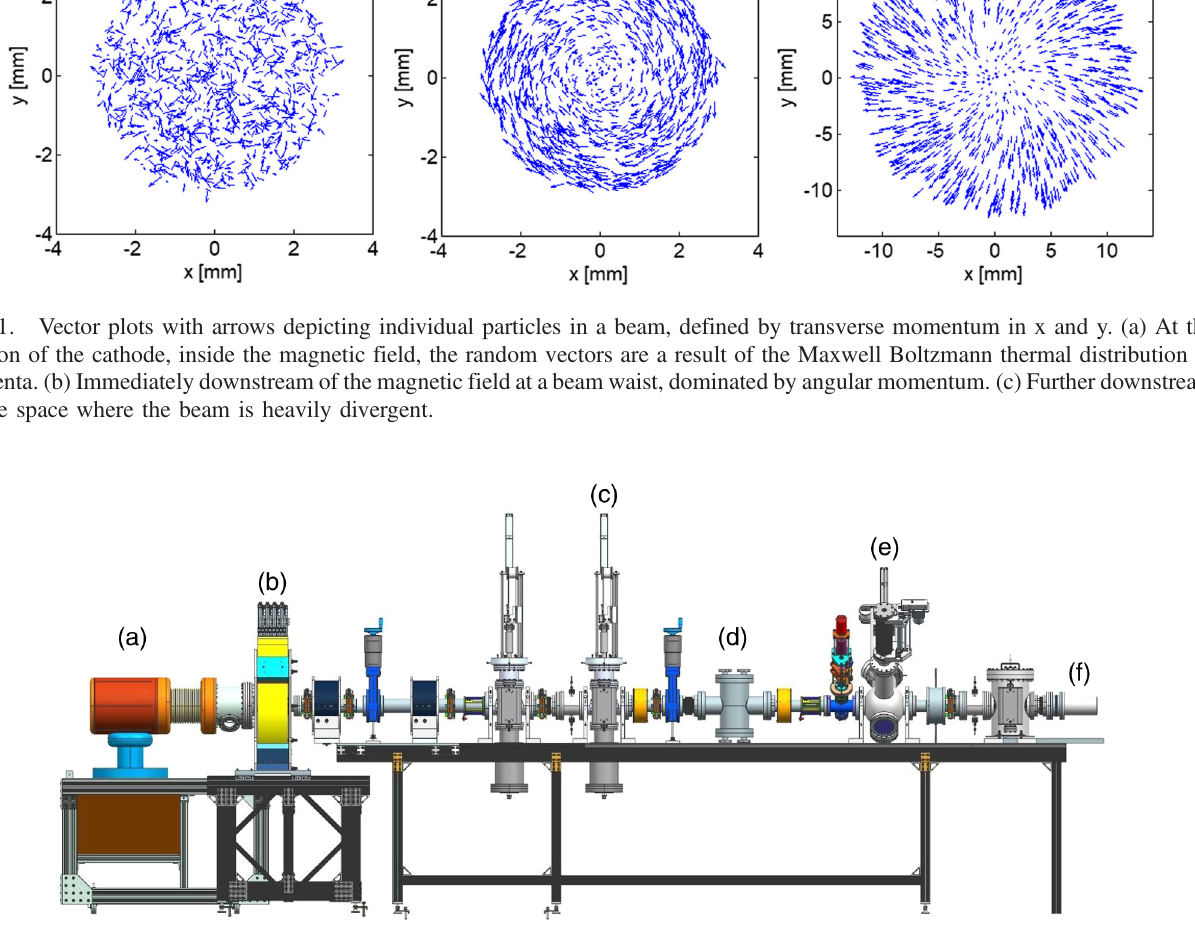
FIG. 2. Mechanical model of the test beamline. (a) thermionic gun (b) magnetizing solenoid (c) housing for 1D pepper-pot (d) deflecting cavity (e) housing for viewer screen (f) beam